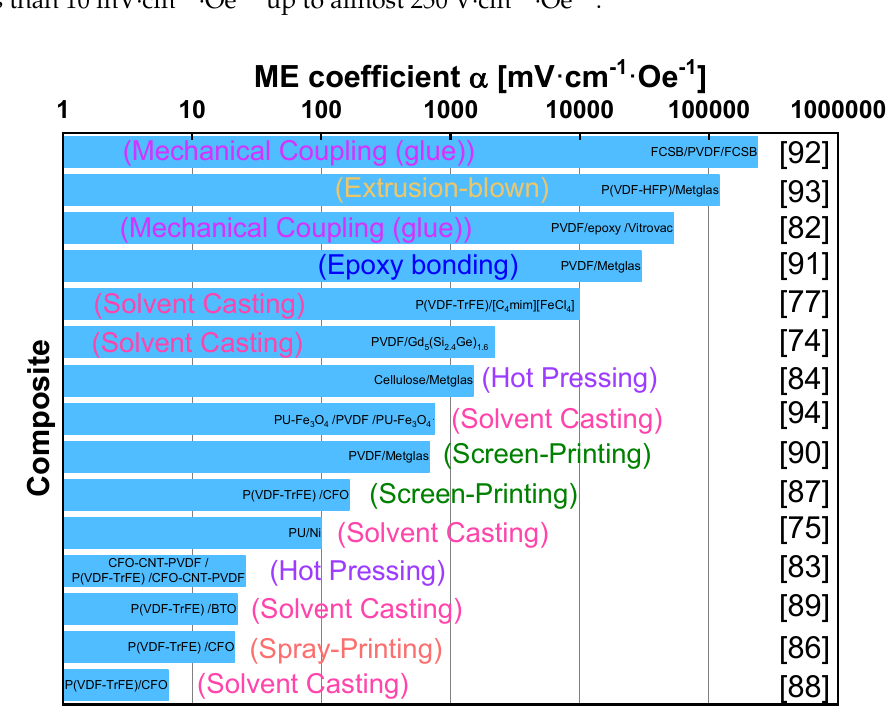
Figure14. Somerepresentativepolymer-basedMEmaterials, andtheirrespectiveMEvoltagecoe ffi Figure 14. Some representative polymer-based ME materials, and their respective ME voltage coefficient.